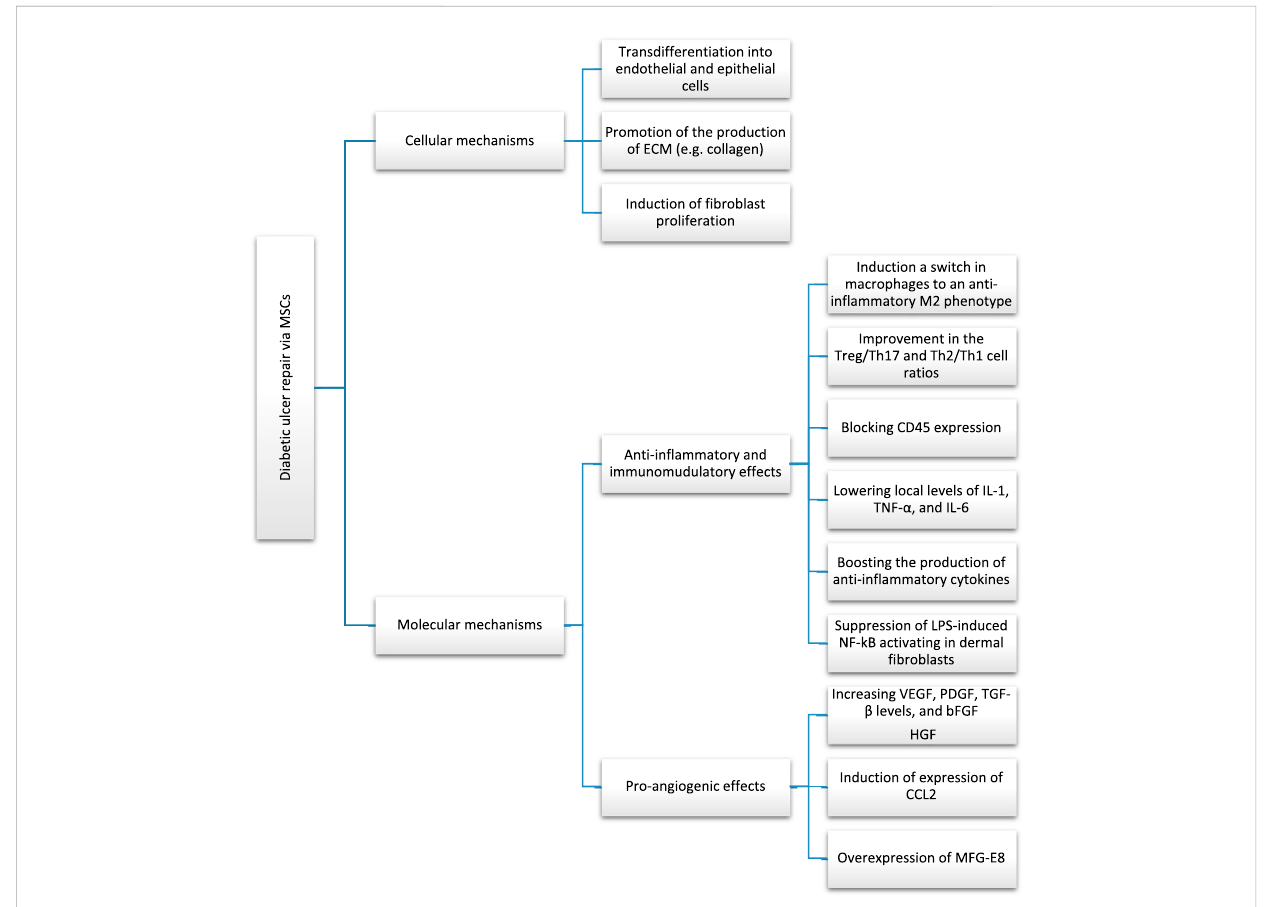
FIGURE 1 Cellular and molecular mechanisms through which MSCs are involved in diabetic foot ulcer